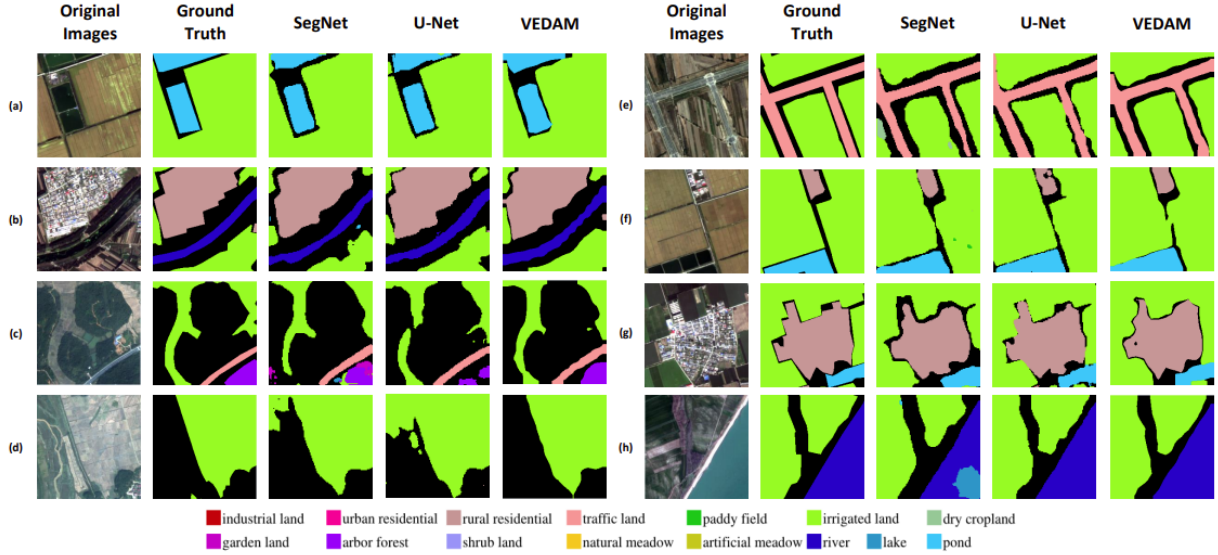
Figure 8. Visualization of segmentation results of SegNet, U-Net, and VEDAM on the GID Da- taset, ( a – h ) represents the visualization results of randomly selected samples. ( a – h ) represents the visualization results of randomly selected